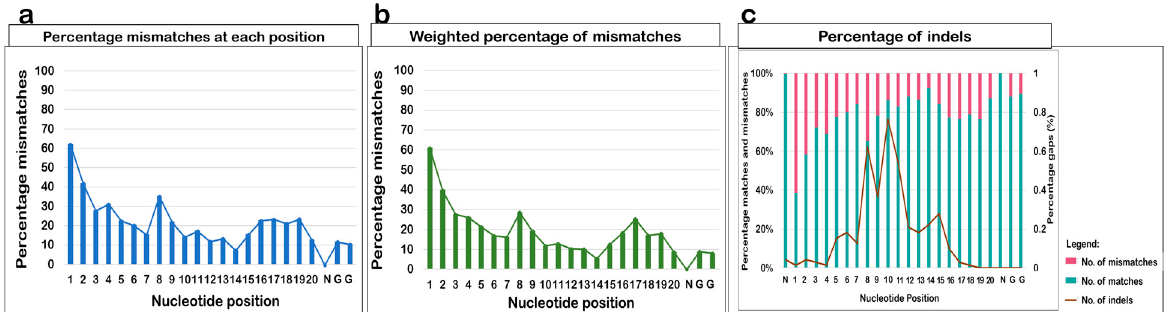
Figure 2. Trend in mismatch tolerance across the length of the protospacer. ( a ) Mismatch tolerance measured on the experimental dataset. ( b ) Mismatch tolerance weighted by experimental cleavage frequency. ( c ) Occurrence of insertions or deletions, represented as gaps, across the length of the protospacer.